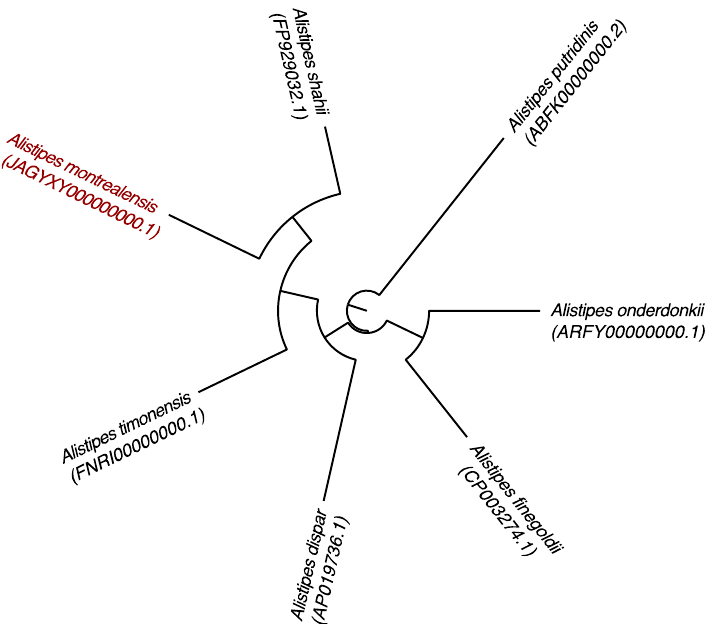
Figure 4. Phylogenetic tree based on whole genome sequence showing the position of Alistipes